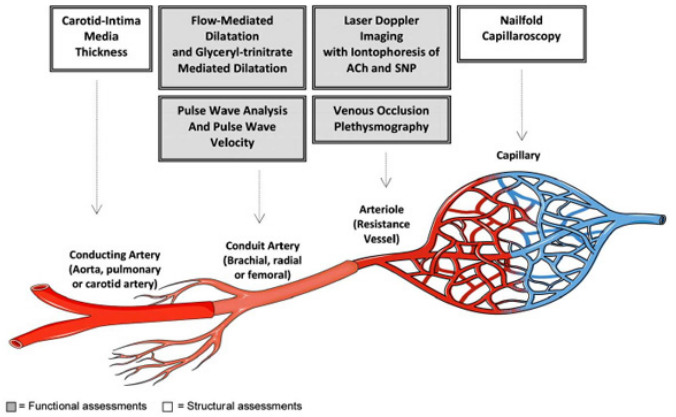
Figure 2. Endothelial function and vascular structure performed in different vascular beds.